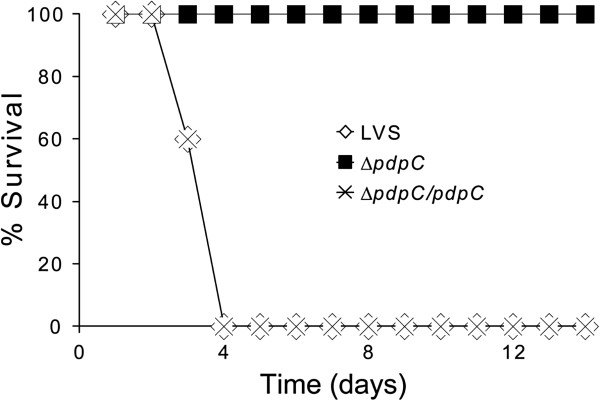
Survival of C57BL/6 mice after intradermal infection with 5 × 107 CFU of LVS or the complemented ΔpdpC mutant, or 1 × 109 CFU of the ΔpdpC mutant (5 mice/group). All mice of the latter group survived until the experiment was terminated after 28 days.